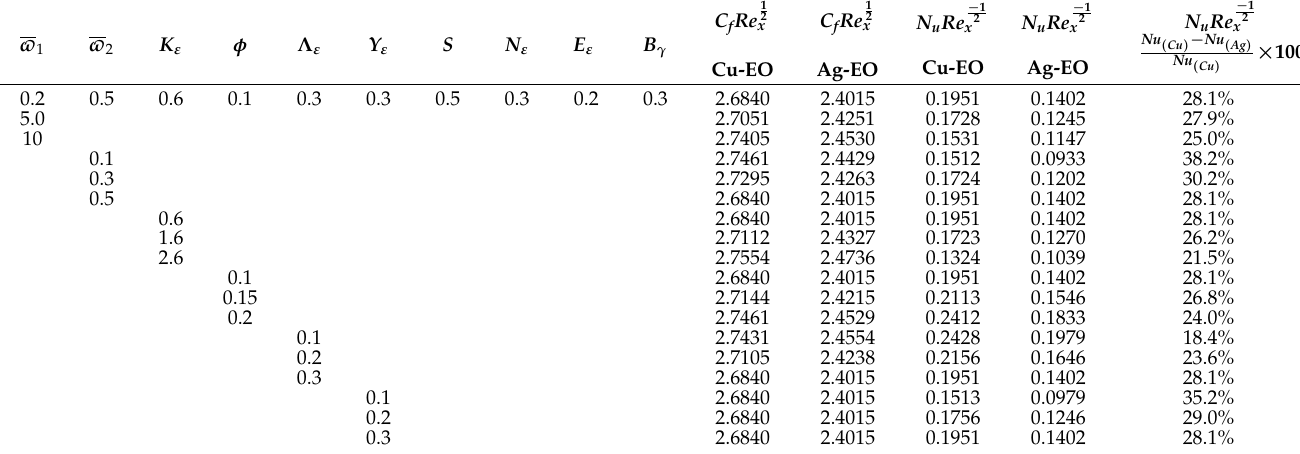
− 1 2 x ) values for Pr =